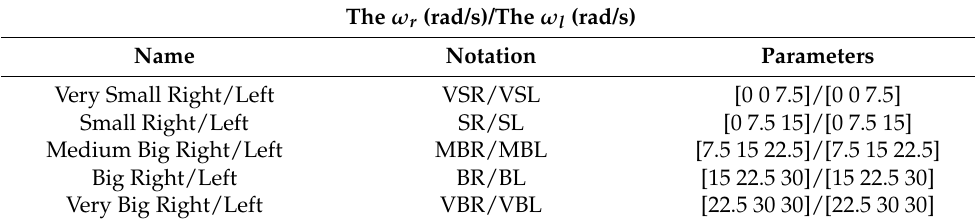
Table 2. Parameters used for outputs of the initial fuzzy logic